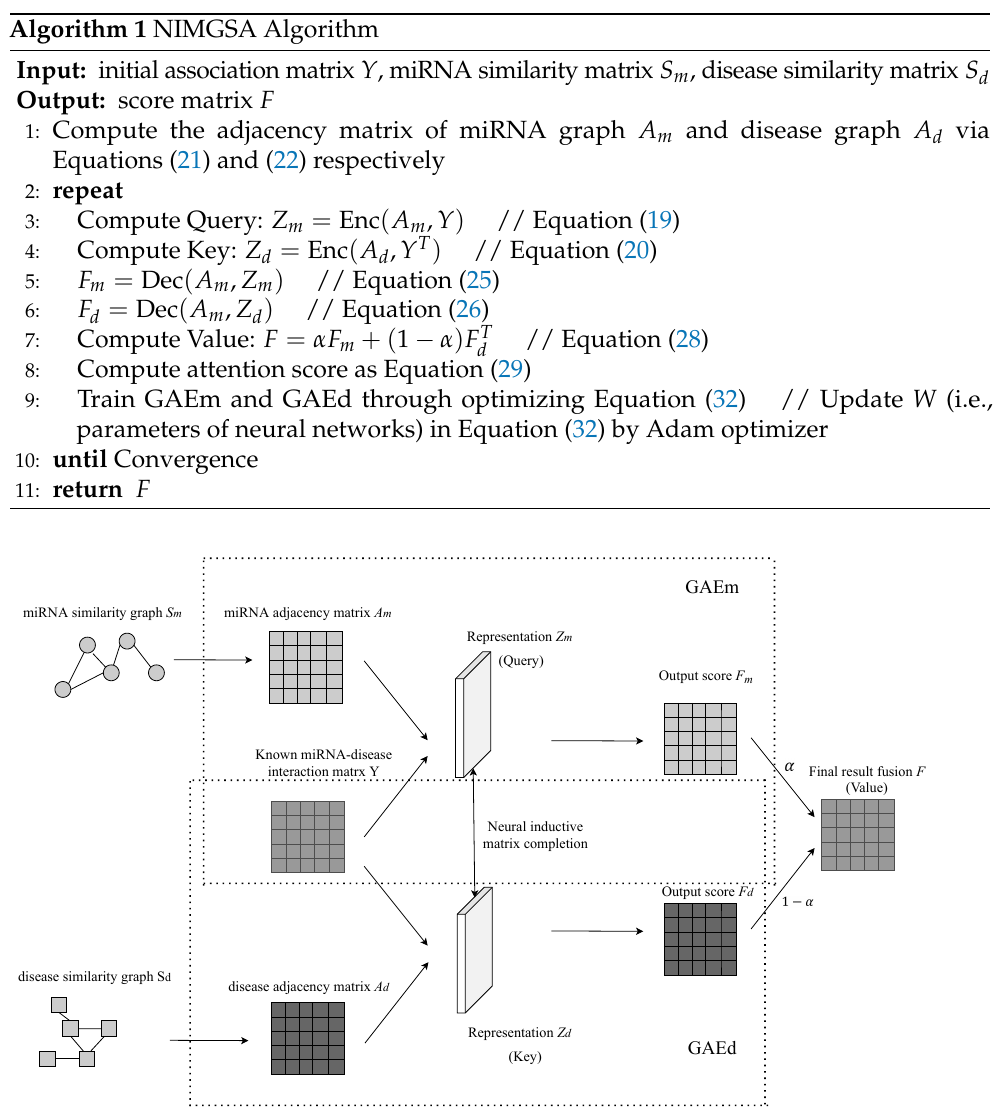
Figure 2. Illustration of NIMGSA. GAEm and GAEd represent graph autoencoders on the miRNA graph and disease graph